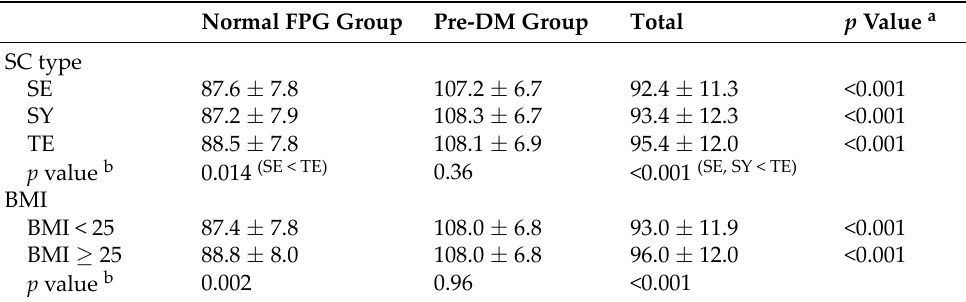
Table 2. FPG values by Sasang constitution type and obesity